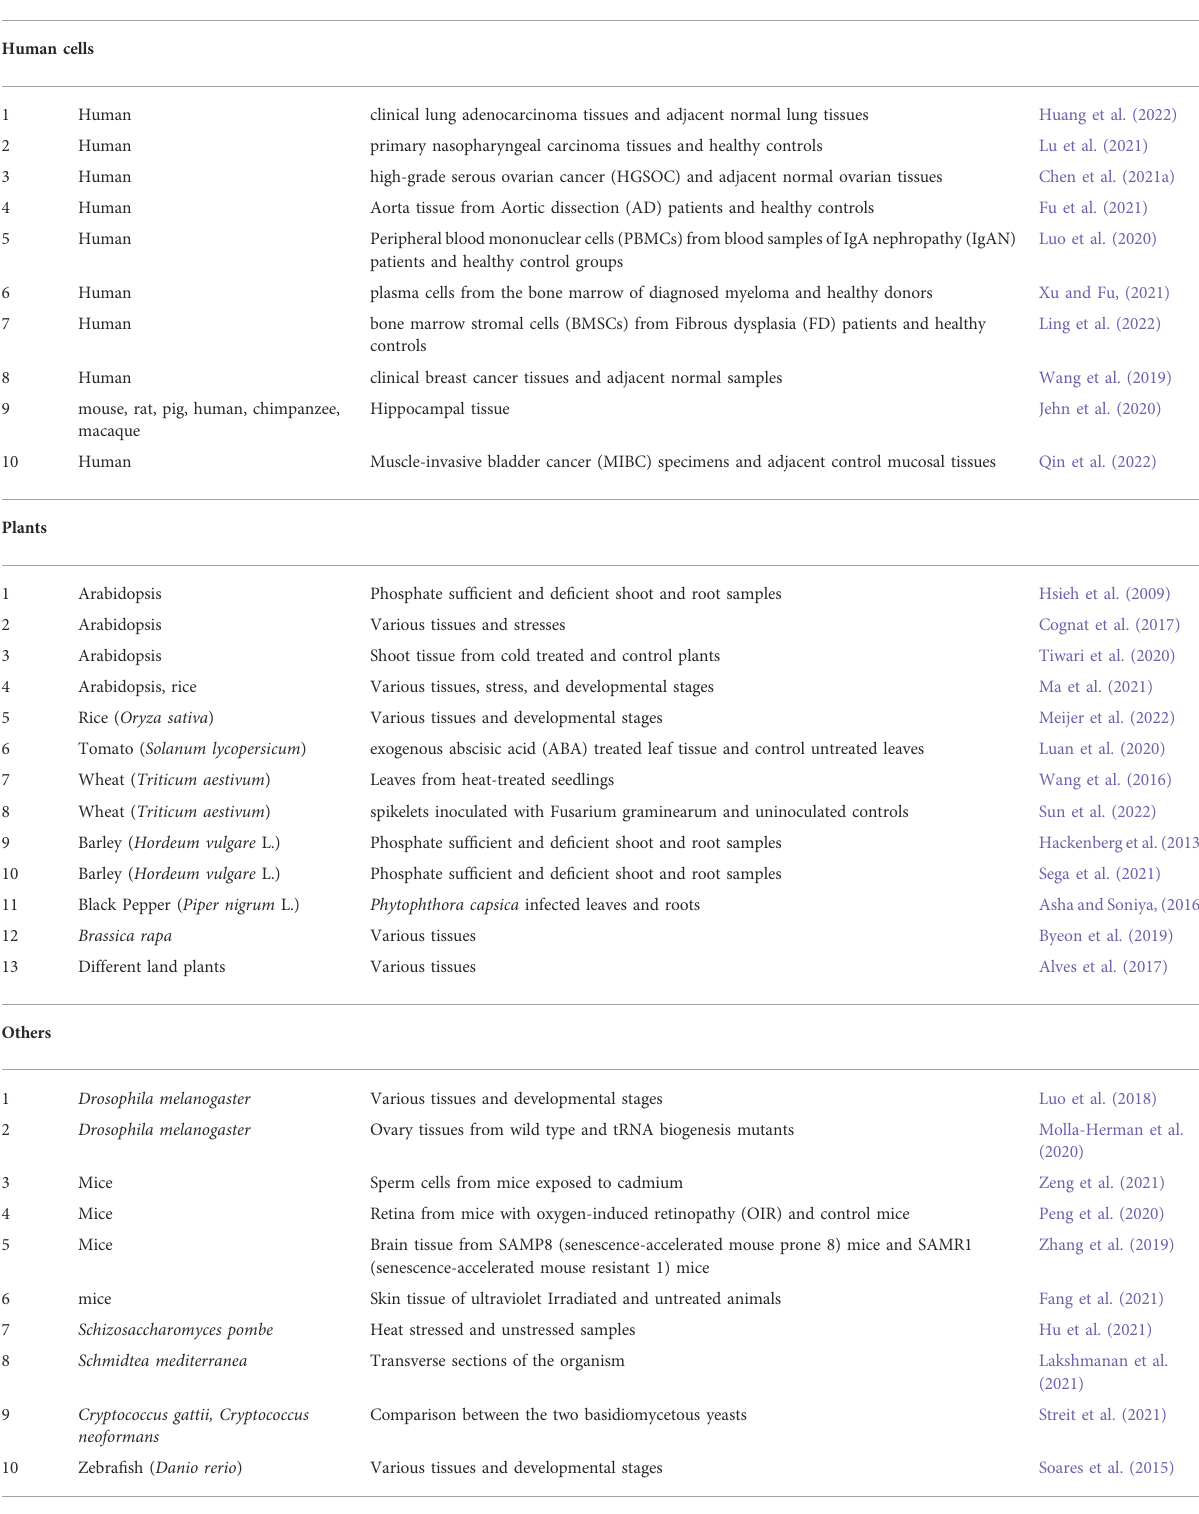
TABLE 1 Differential Expression pro fi ling of tRFs in various organisms. Sl.